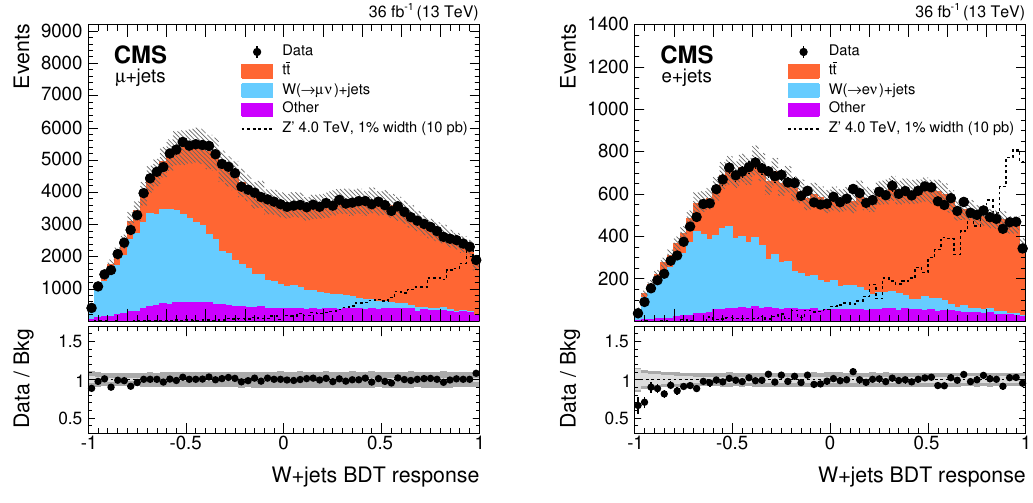
Figure 3 . W+jets BDT distributions in the muon (left) and electron (right) single-lepton channel. The SR is de(cid:12)ned as events with W+jets BDT (cid:21) 0 : 5. The contribution expected from a 4 TeV Z 0 boson, with a relative width of 1%, is shown normalized to a cross section of 10 pb. The hatched band on the simulation represents the statistical and systematic uncertainties. The lower panels in each plot shows the ratio of data to the SM background prediction and the light (dark) gray band represents statistical (systematic) uncertainty. The error bars on the data points indicate Poisson statistical